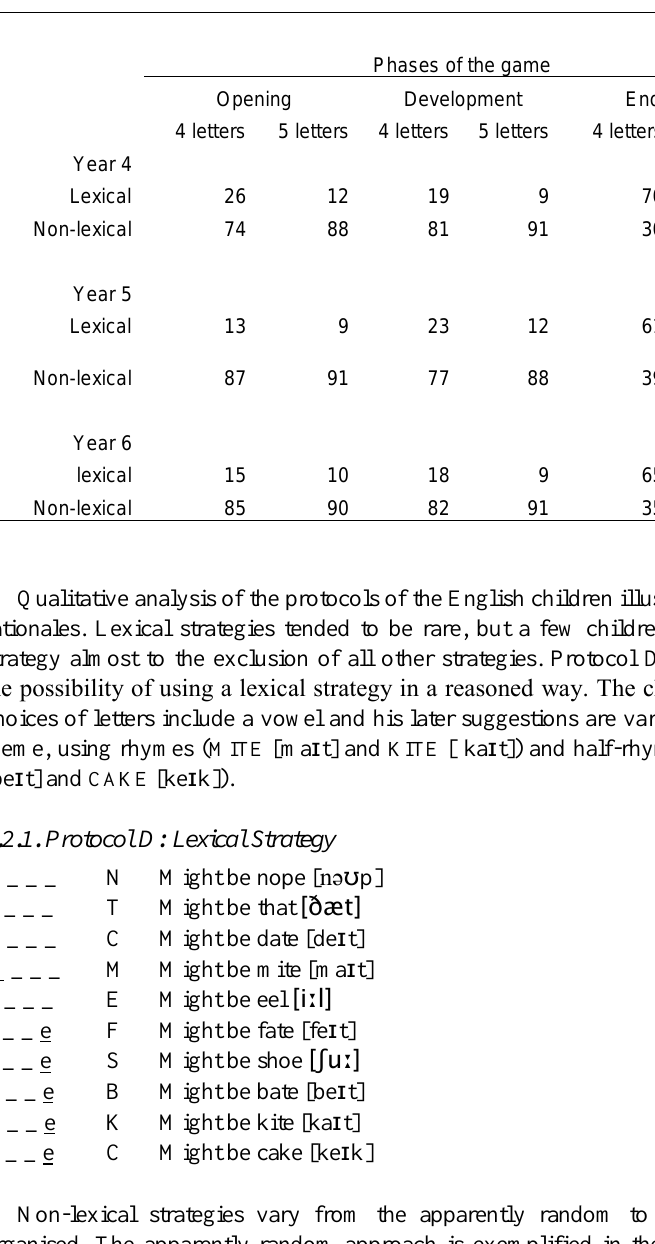
Table 4. Percentage of lexical and non-lexical strategies used by English children